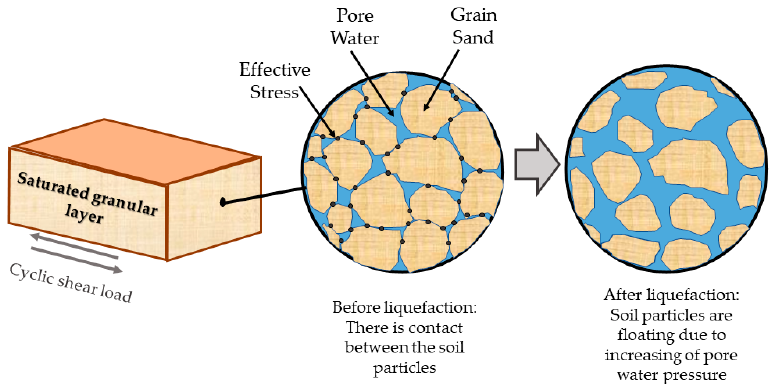
Figure 1. Liquefaction mechanism: soil particles floating due to the increment of pore water pressure.